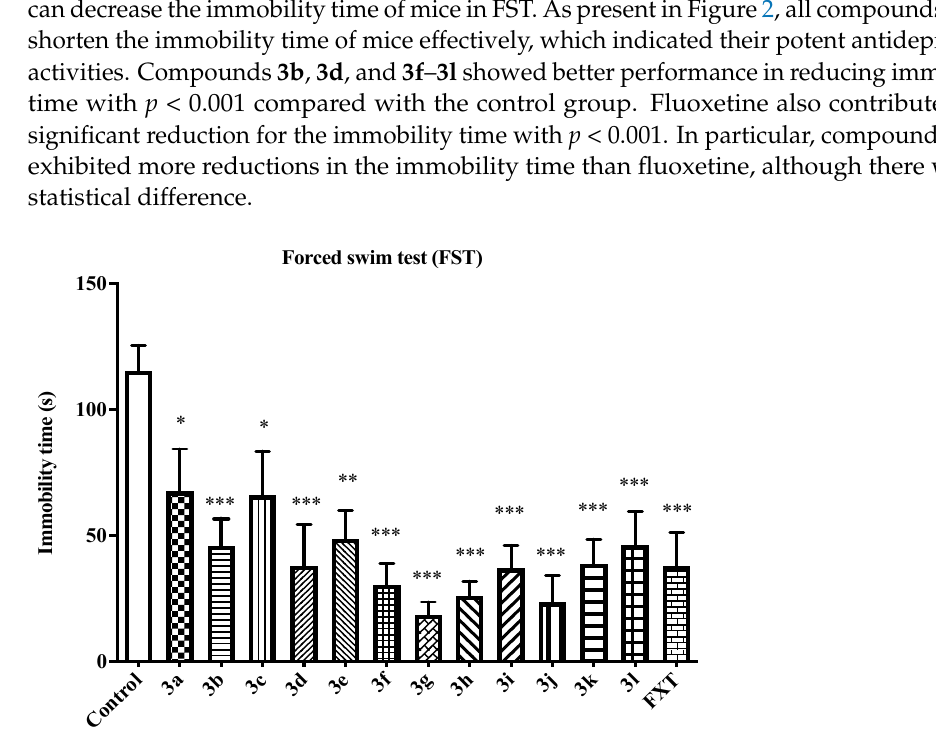
TST when taken at 50 mg/kg. This result further confirmed that compound 3g has potent antidepressant activity. Figure 4. Effects of compound 3g and FXT (i.p., 50 mg/kg) on the duration of immobility time in the TST. Ten animals were used for each group. ** p < 0.01 compared to the control group, *** p < 0.001 compared to the control group. To exclude the possible false-positive of compound 3g due to its effect on locomotor activity, the effect of compound 3g on the locomotor activity of mice was assessed via an open-field test. The open-field test is a widely used behavioral test for the evaluation of the effects of drugs on autonomic activities and the exploratory behavior of animals [36]. As shown in Figure 5, compound 3g showed no significant effect on locomotor activity. There was no significant difference in the crossing, rearing, and grooming of mice